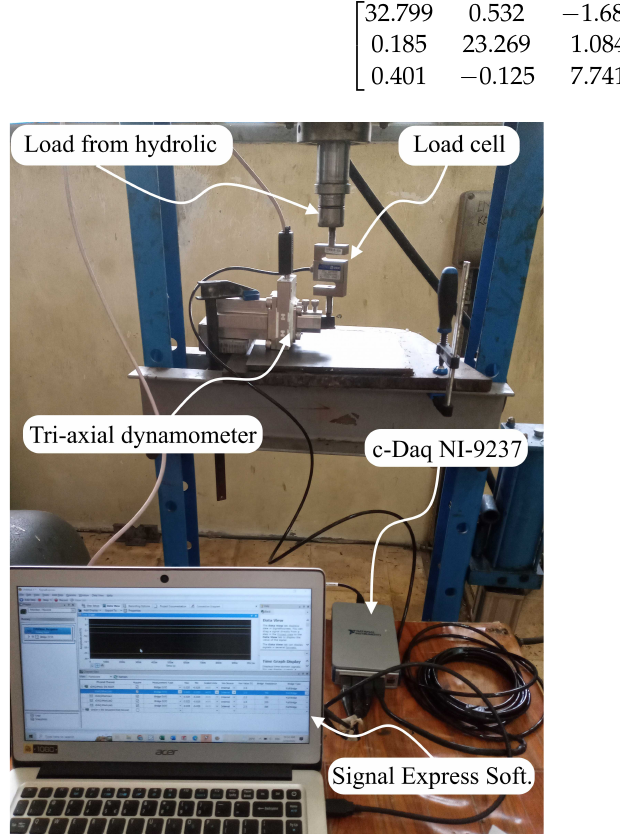
Figure 8. Dynamometer setup in static calibration test.